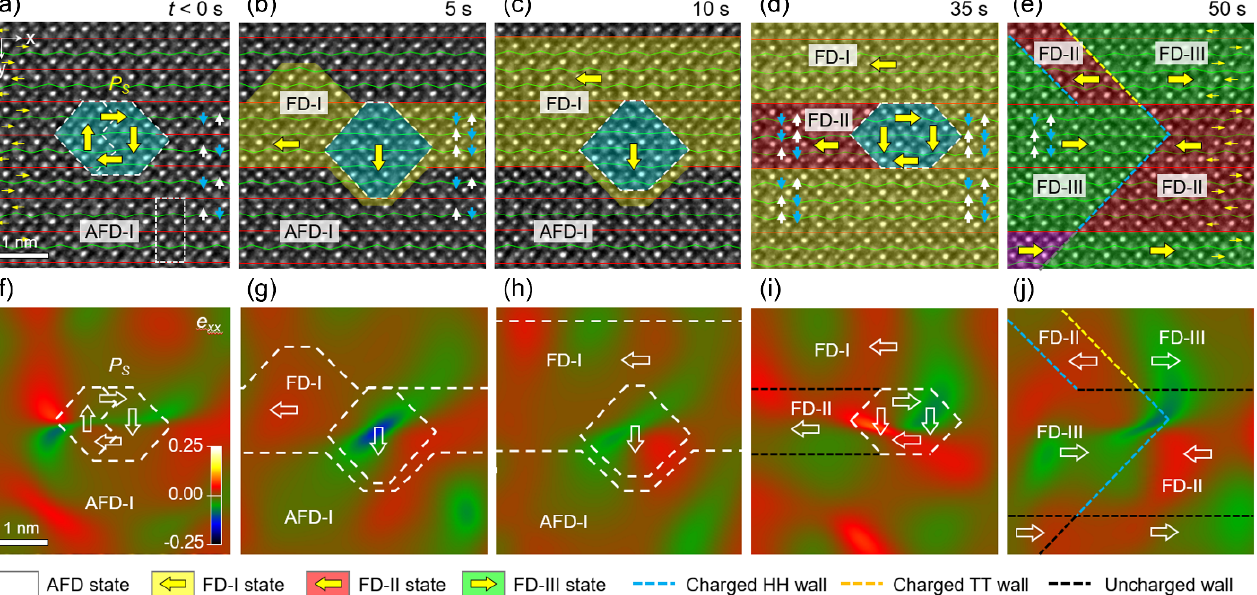
Figure 8. Defect-core-induced unit-cell-wise energy storage pathway in [001] O -oriented PbZrO 3 . ( a-e ) Phase and domain structure evolution as a function of electron-beam irradiation time (dose rate = 3.8 × 10 6 e/nm 2 ⋅ s). The cyan shadow and thick yellow arrows denote the defect core and polarization, respectively. ( f–j ) Corresponding lattice strain e xx (horizontal [100] O direction) maps obtained using geometric phase analysis (GPA) [118].